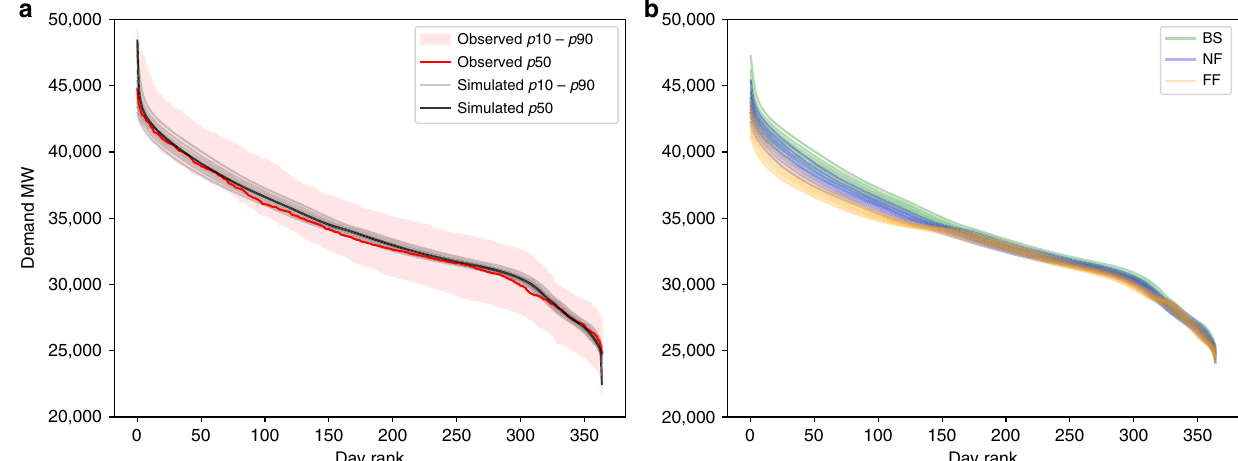
Fig. 8 Load duration curves (LDC) to determine the demand model performance. a Comparison of the observed LDC for 2012 – 2017 in red, with 100 simulated LDCs from the 100 W@H climate samples. Note that the observed uncertainty range is considerably larger due to other socioeconomic factors such as changing demand. b Comparison of the baseline, near future and far future LDCs using nine percentiles across the climate